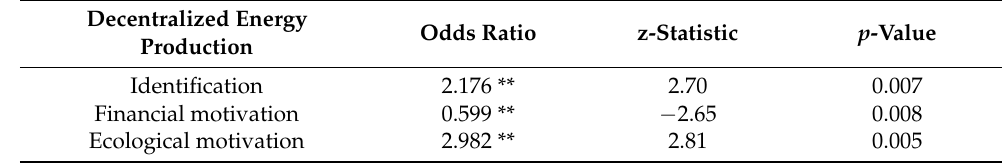
Table 3. Logistic regression: people believe in decentral energy production without big power plants. Decentralized Energy Odds Ratio z-Statistic Production